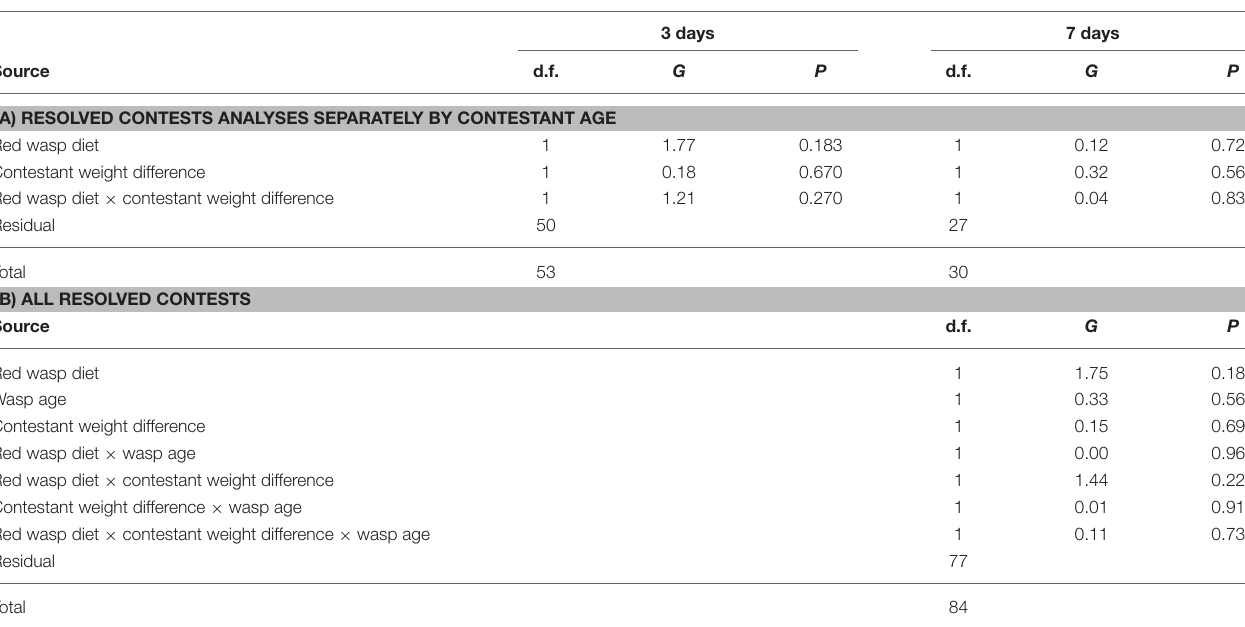
TABLE 4 | Potential influences on outcomes of resolved